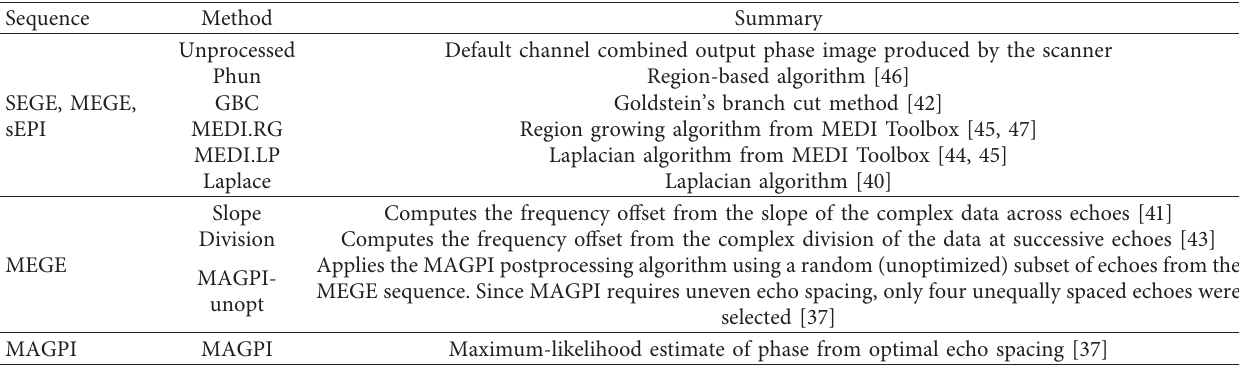
Table 2: All phase estimation methods. The first six methods were combined with other common phase processing techniques to process the multiecho data, as described in the Methods